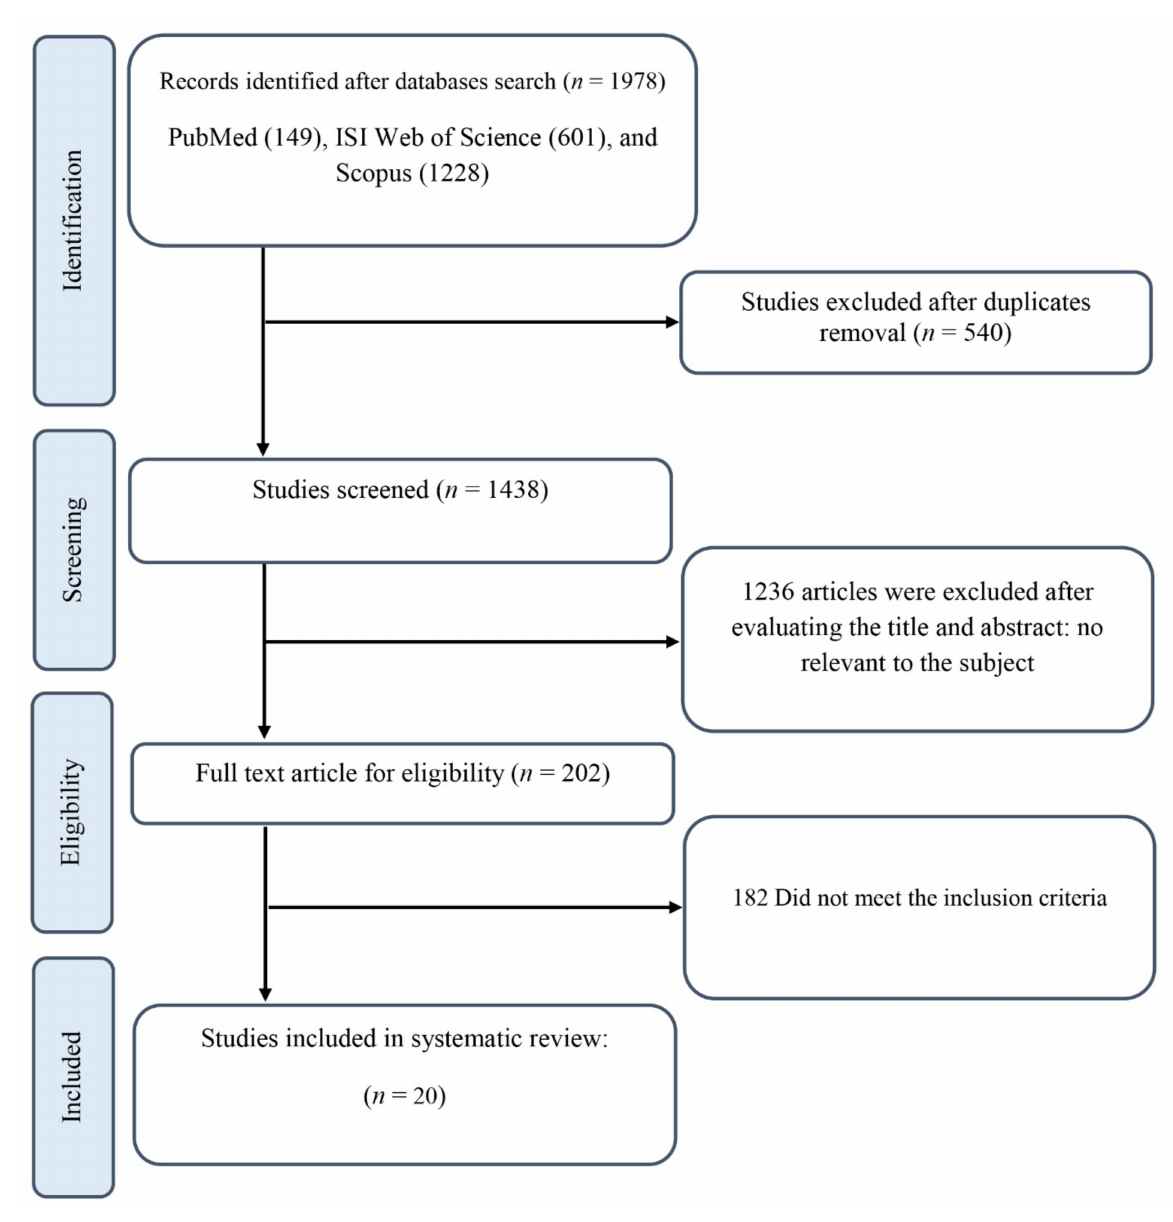
Figure 1. The Preferred Reporting Items for Systematic Review and Meta-analysis(PRISMA)